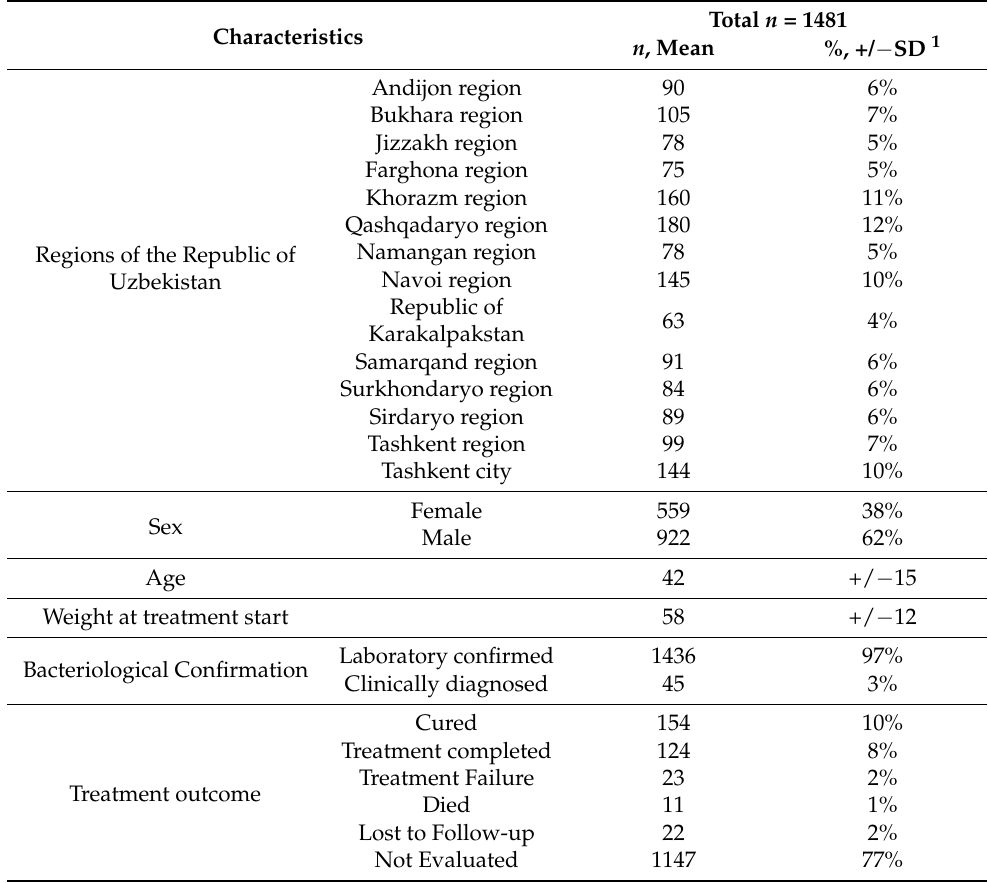
Table 1. Characteristics of multidrug-resistant (MDR)/rifampicin (RR)-tuberculosis (TB) patients registered from 2012 to 2018 in Uzbekistan and assessed under the project of “Evaluation of the TB drug usage for treating MDR TB”.